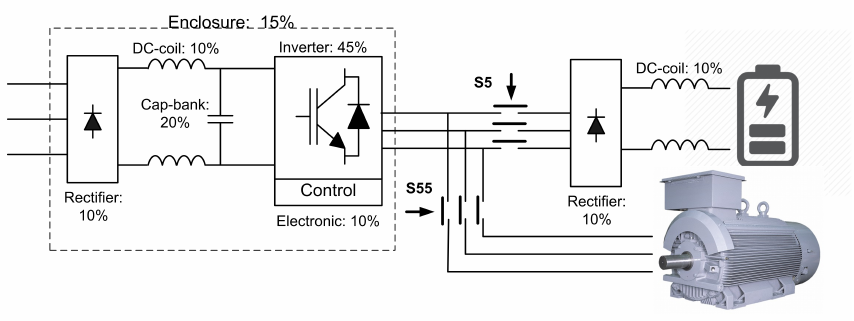
Figure 9. Use of drive VFC to charging EV